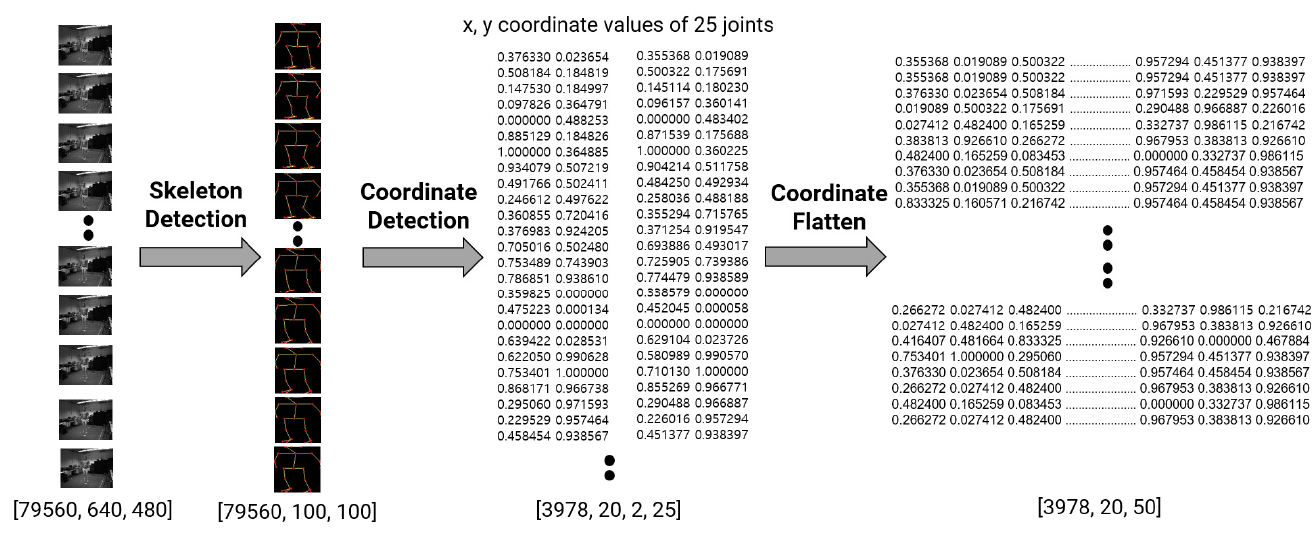
Figure 3. Skeleton coordinate input data for deep learning.